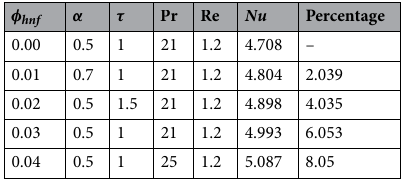
Table 3. Percentage enhancement in Nusselt number.